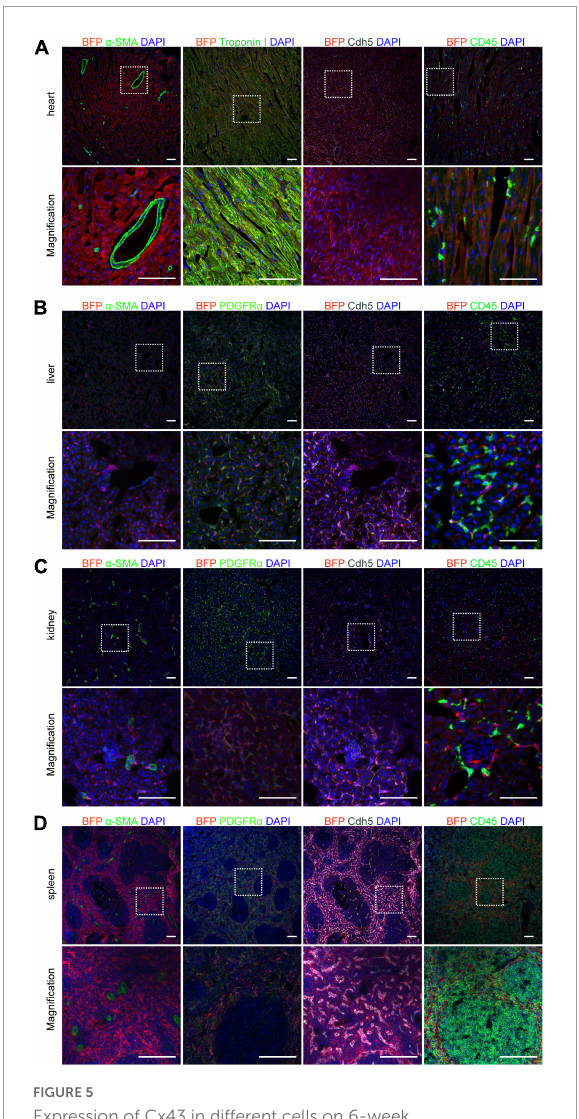
FIGURE5 Expression of Cx43 in different cells on 6-week Cx43-BFP-GFP/ + mice. (A) Immunostaining for BFP, Cdh5, CD45, α -SMA, and Troponin I on heart sections; (B–D) immunostaining for BFP, α -SMA, PDGFR α , Cdh5, and CD45 on liver, kidney and spleen sections. The high magnification images of organs in areas labeled with the square dotted frame. Scale bar = 100 µ